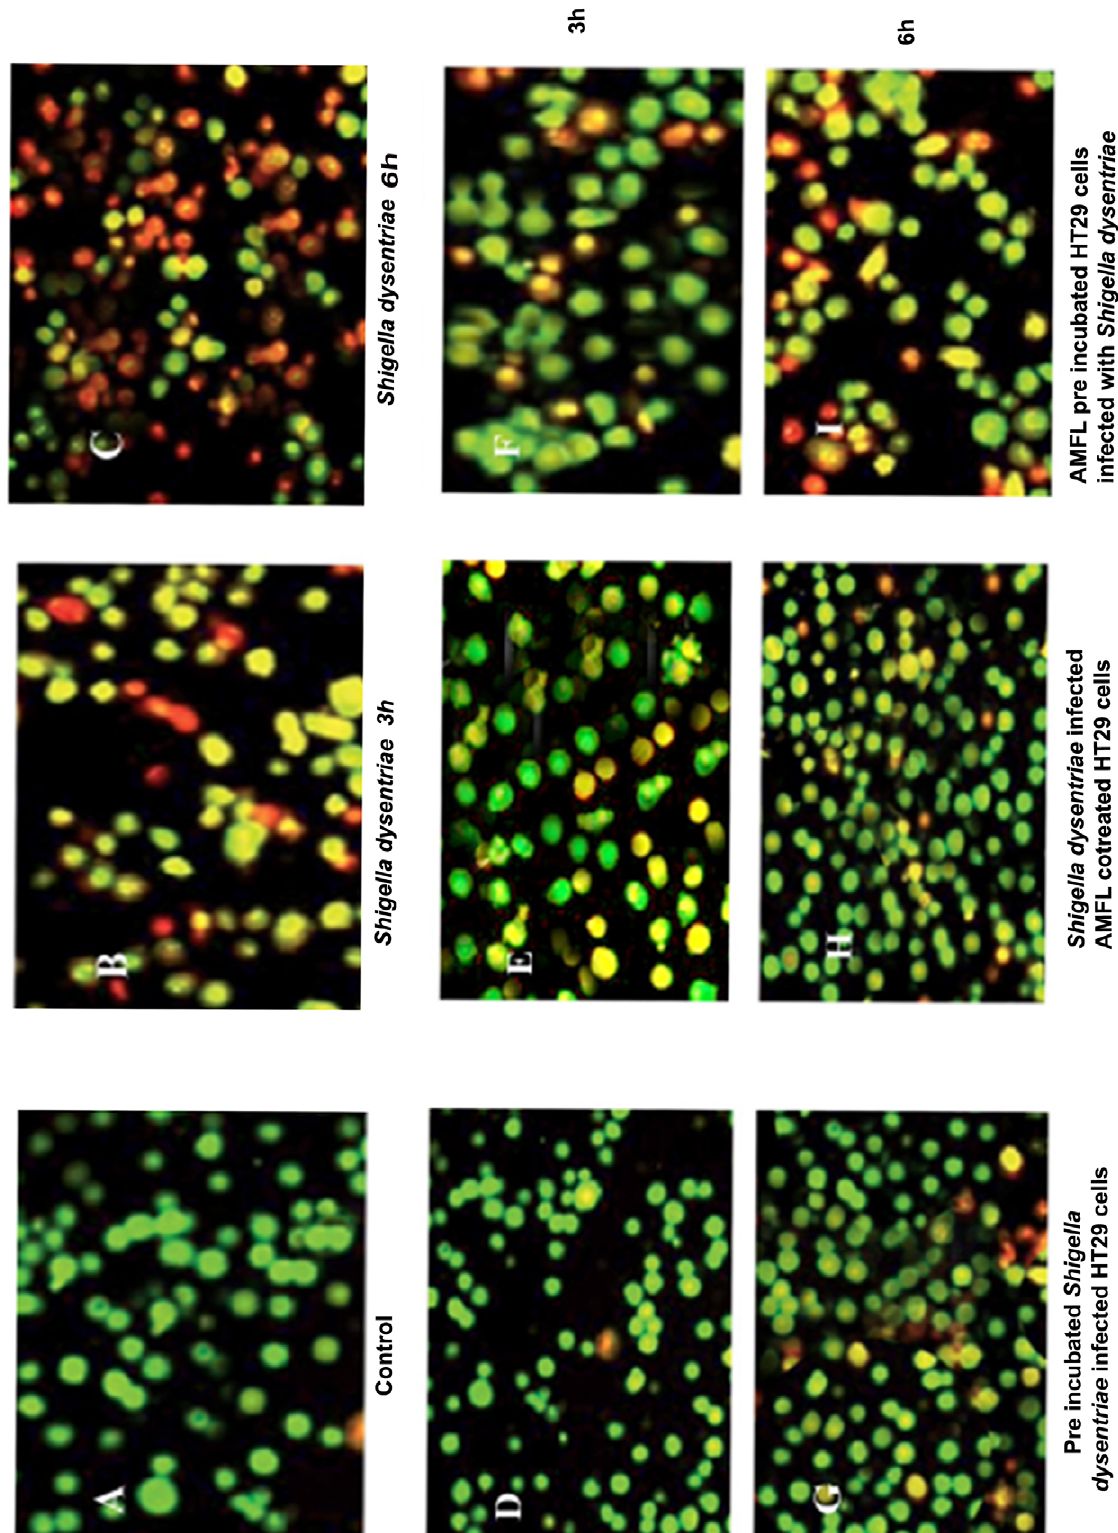
Figure 9. Apoptosis of HT 29 cells infected with wild and lectin incubated bacteria. a. Control HT 29 - normal nuclei with green fluorescence b. wild Shigella dysenteriae infected HT 29 cells at 3 h showing early apoptotic cells along with greenish yellow fluorescence. C. wild Shigella dysenteriae infected HT 29 cells at 6 h showing condensed nuclei that were brightly stained with ethidium bromide and appeared red d & g. Shigella dysenteriae preincubated with lectin for 1 h infected HT 29 cells at 3 h & 6 h respectively, showing early apoptotic cells along with greenish